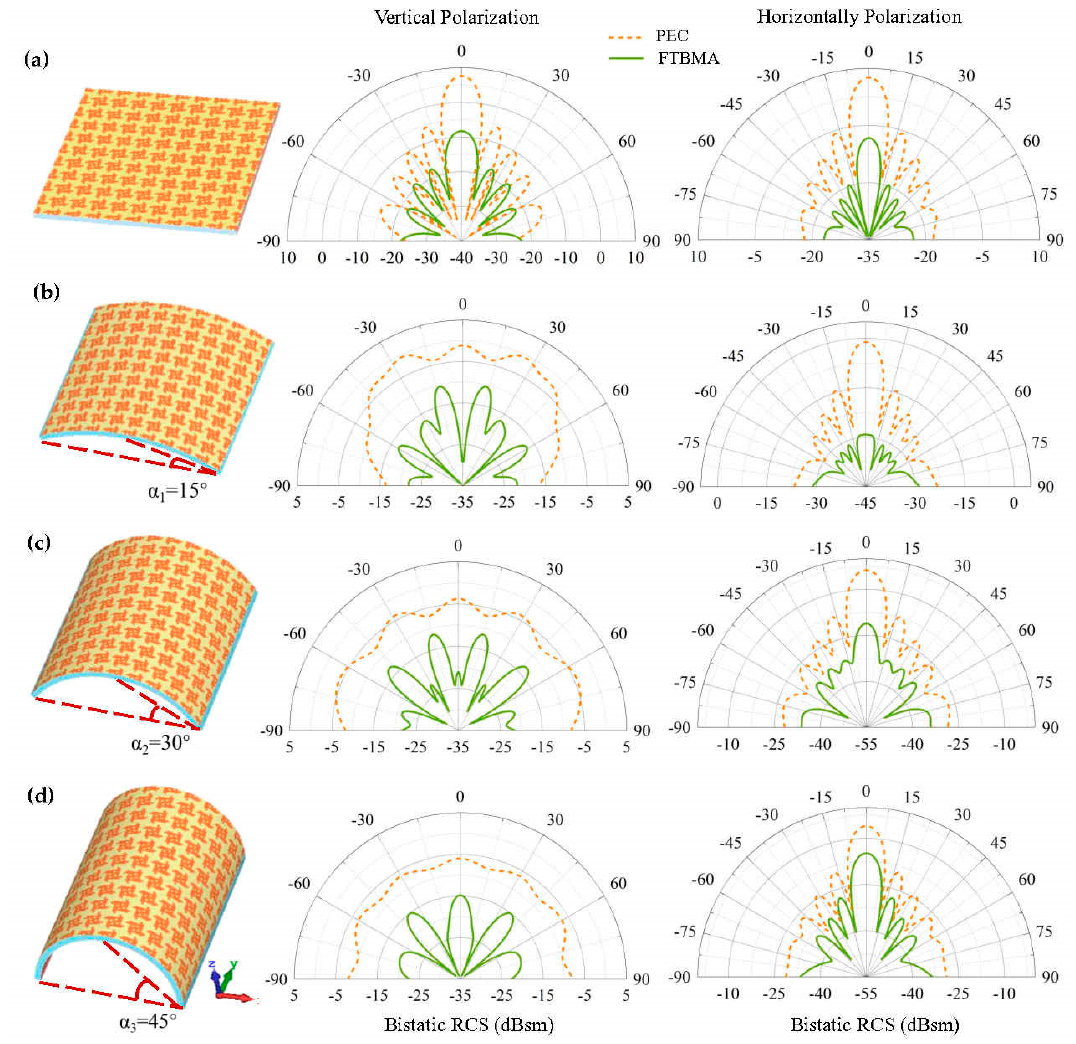
Figure 7. Schematic diagram of FTBMA ( left ) and bistatic RCS comparison of the metal plate and the FTBMA for vertical ( center ) and horizontal ( right ) polarized incident waves at 10 GHz: ( a ) both flat structures; ( b − d ) both curved structures with bending angles of α 1 = 15°, α 2 = 30°, α 3 = 45°, respectively.